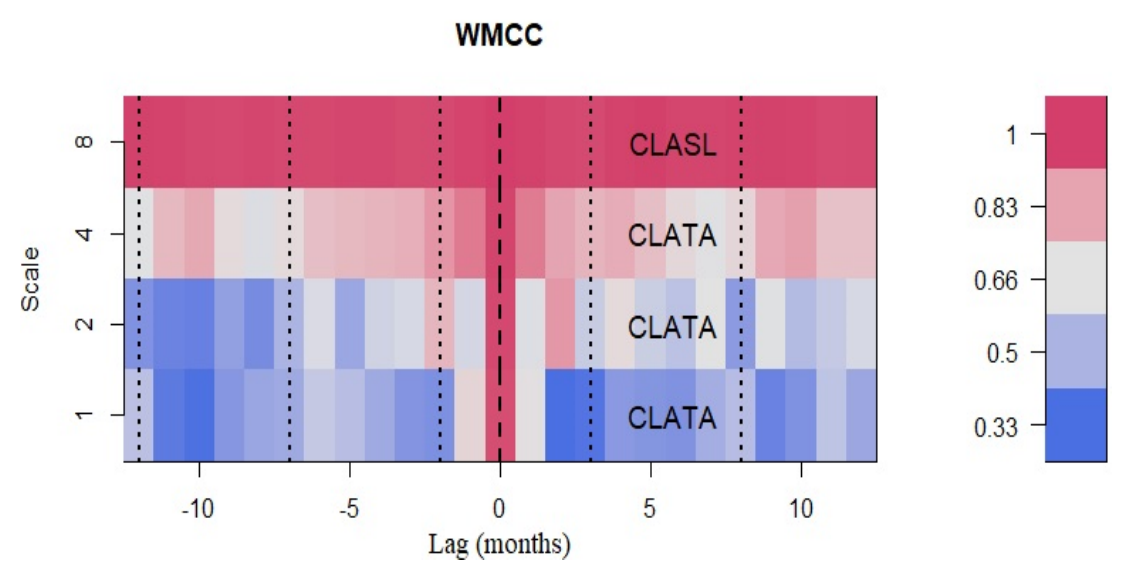
Figure 13. WMCC among the indicators of GSE, banking sector financial Soundness, and interest rates.